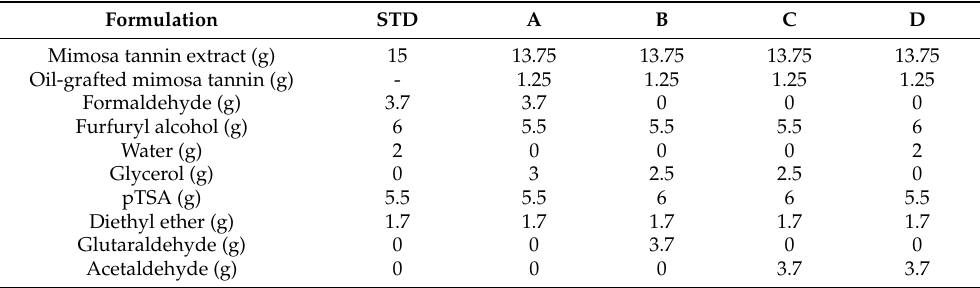
Table 1. Composition of standard tannin-based foams and tannin-based foams formulated with oil-grafted